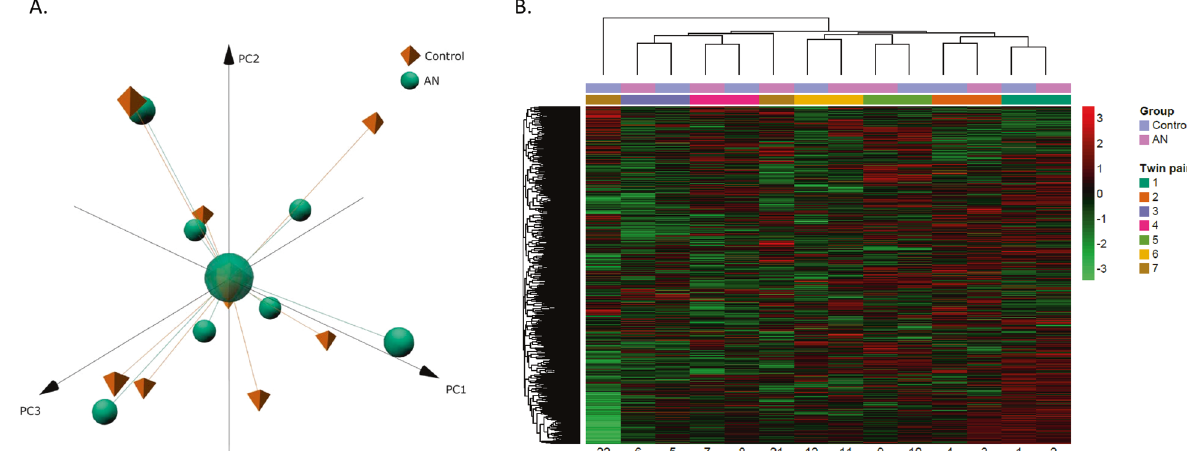
Fig. 2 Analysis of the global DNA methylation pro fi le in the twin cohort. A Representation of the Principal Component Analysis (PCA) on the methylation data. Centroids of each group of patients are represented by different shapes and colours. B Heatmap with a random sample of 5000 CpGs from the twin cohort. Z -score colour scale ranges from green for lower methylation to red for higher methylation levels.